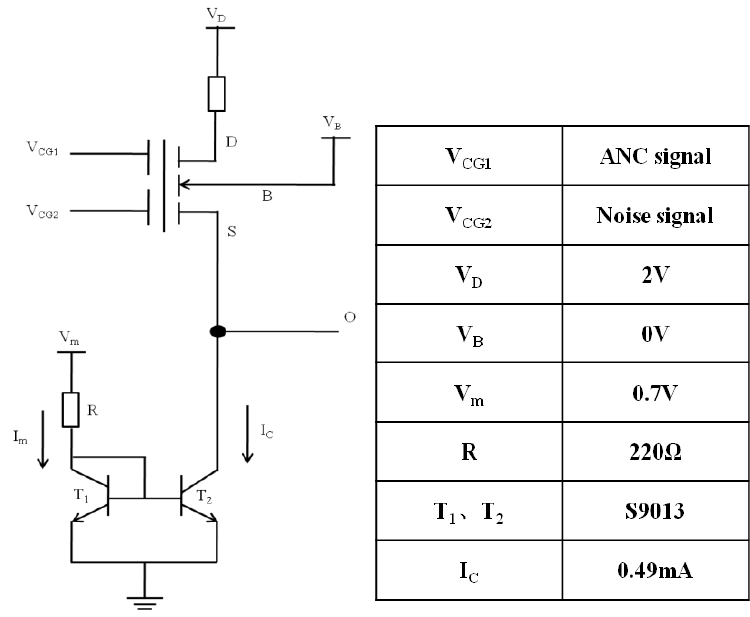
Figure 9. The circuit with source follower mode, where a current mirror, composed of two transistors 𝑇 1 and 𝑇 2 and a resistor 𝑅 , is used to provide a constant saturation current 𝐼 𝐶 , and 𝑉 𝐷 is set to 2 V to ensure the device is in the saturation state.